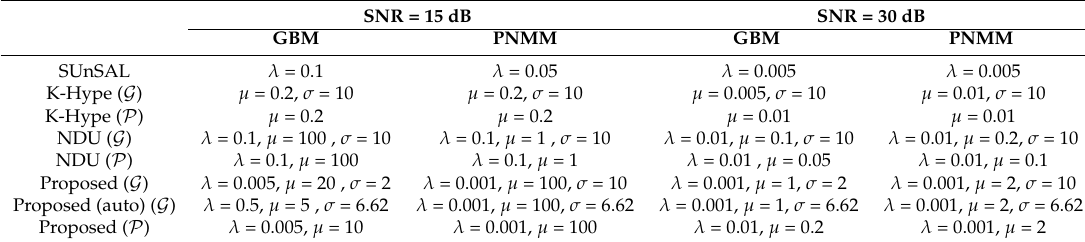
Table A1. The selected algorithm parameters for S 1 .